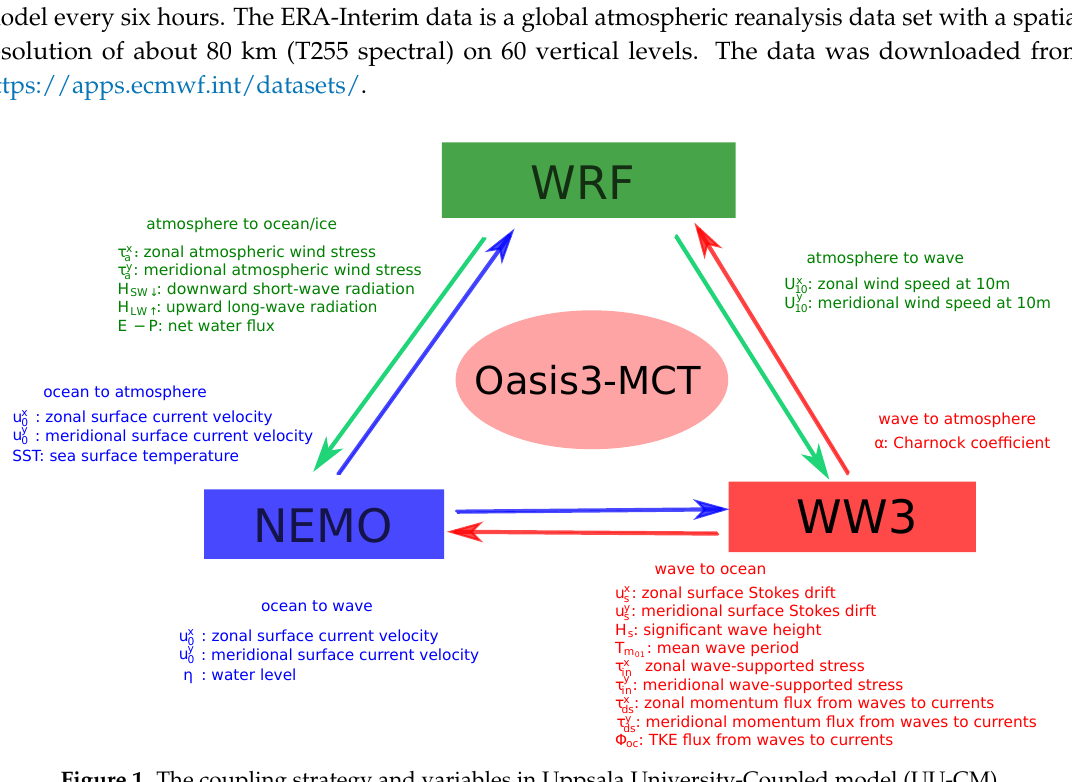
Figure 1. The coupling strategy and variables in Uppsala University-Coupled model